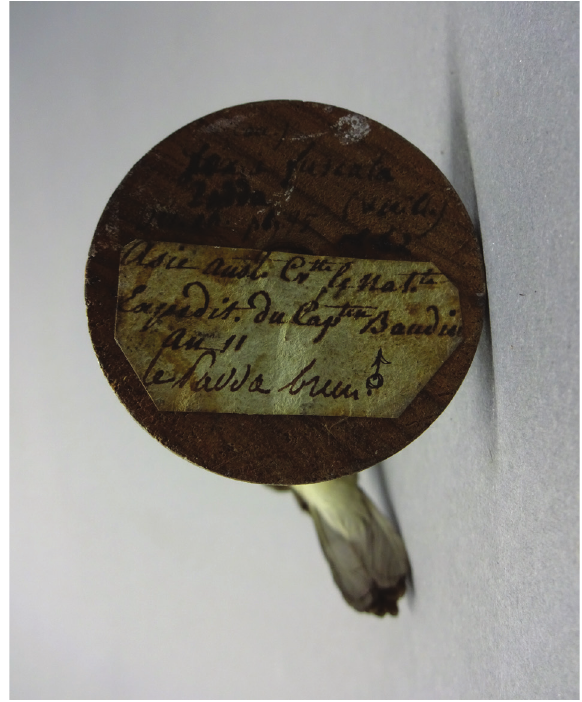
Figure 1. MNHN A.C. 6490: Pedestal underside of Loxia fus- cata . It shows a sticker glued. The same stickers are used on multiply specimens collected in either Australia and Timor. The handwriting is from Louis Dufresne and only used on speci- mens brought back with Le Naturaliste